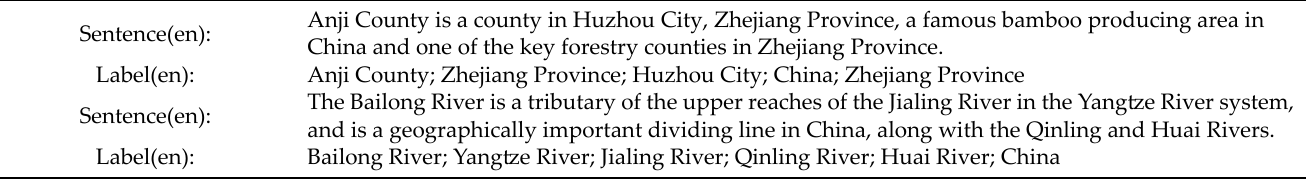
Figure 1. Overall workflow of ChineseNERAnno. Table 5. Some samples of TPCNER.